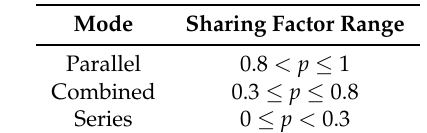
Table 6. Sharing factor ranges.